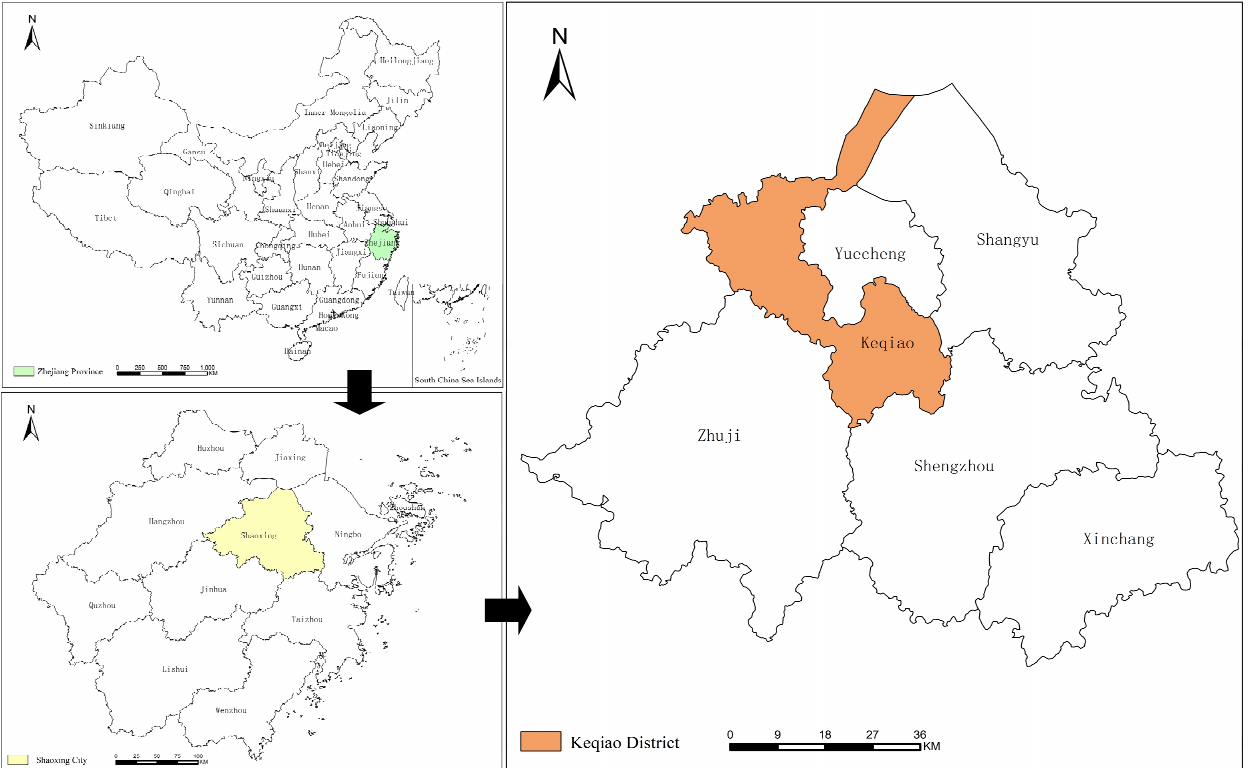
Figure 4. Study area: Keqiao District, Shaoxing City, Zhejiang Province.